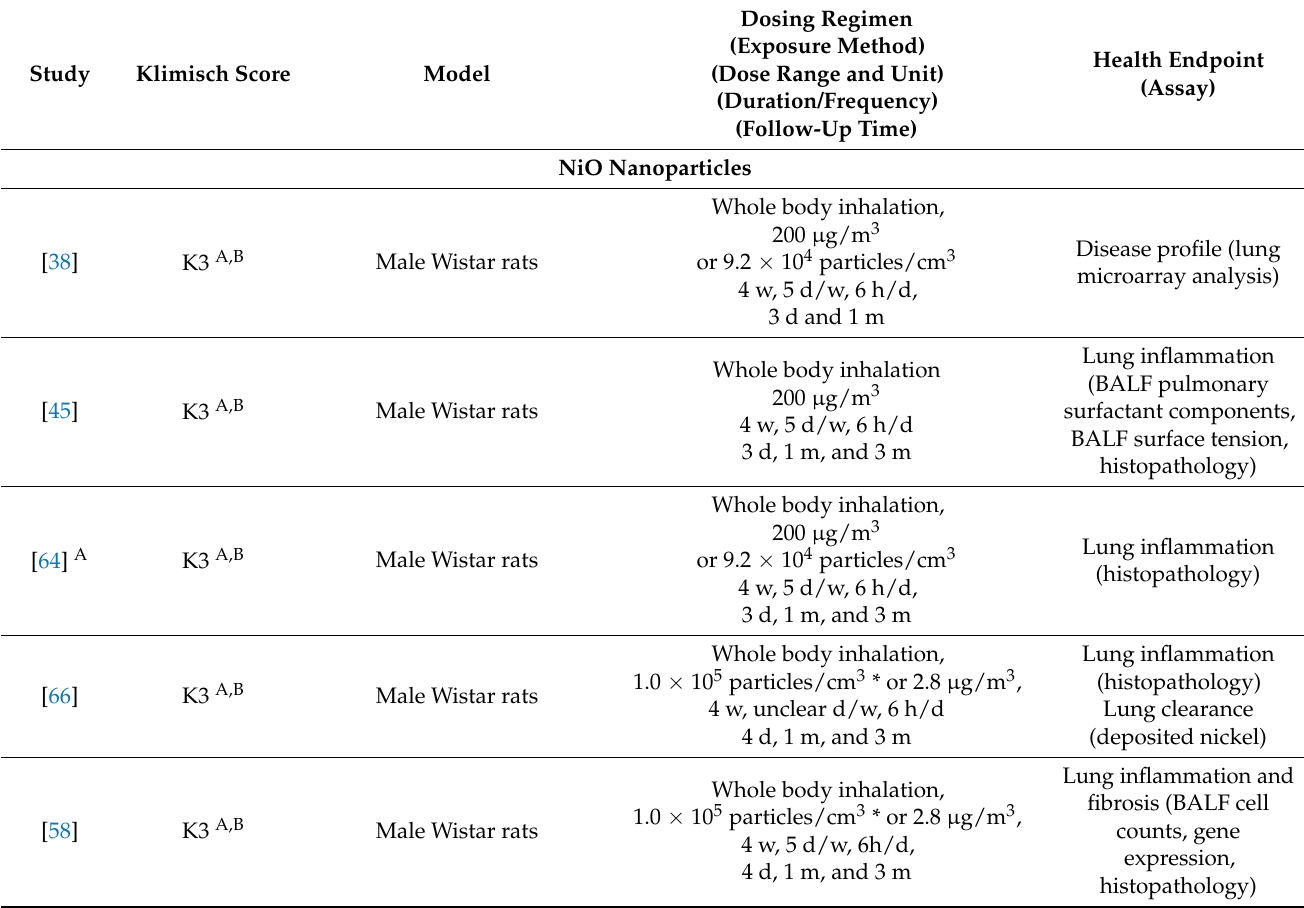
Table 2. In vivo literature associated with lung inflammation and damage endpoints after exposure to oxidic nickel nanoparticles. Studies are arranged by nanoparticle type, followed by exposure method.